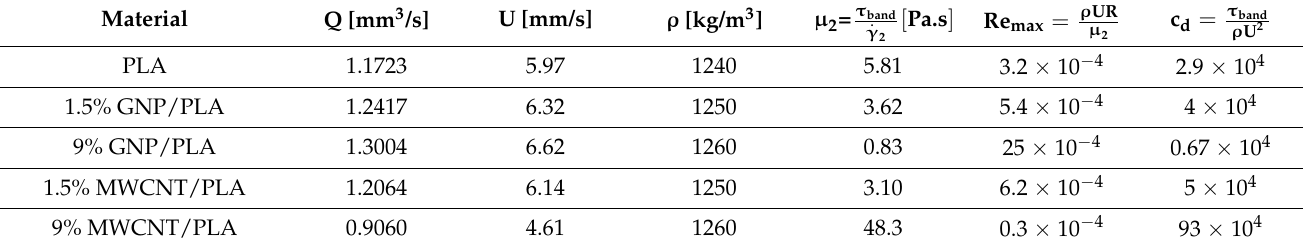
Table 3. Flow and material parameters in the